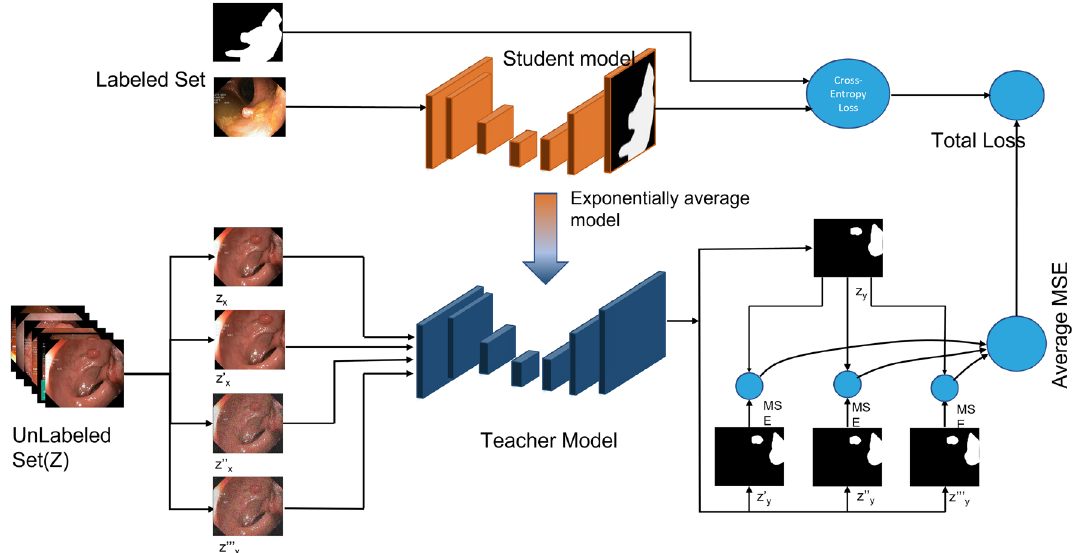
Figure 1. Our proposed method for semi-supervised medical image segmentation (we utilize Kvasir-SEG data 44 as an example). The weight of the teacher model is the exponential moving average (EMA) of the student weights. The total loss is a weighted combined loss of the cross-entropy on labeled data and mean-square error (MSE) on the unlabeled set. Note that we apply transformation-consistent approach on the unlabeled data during perturbations 45